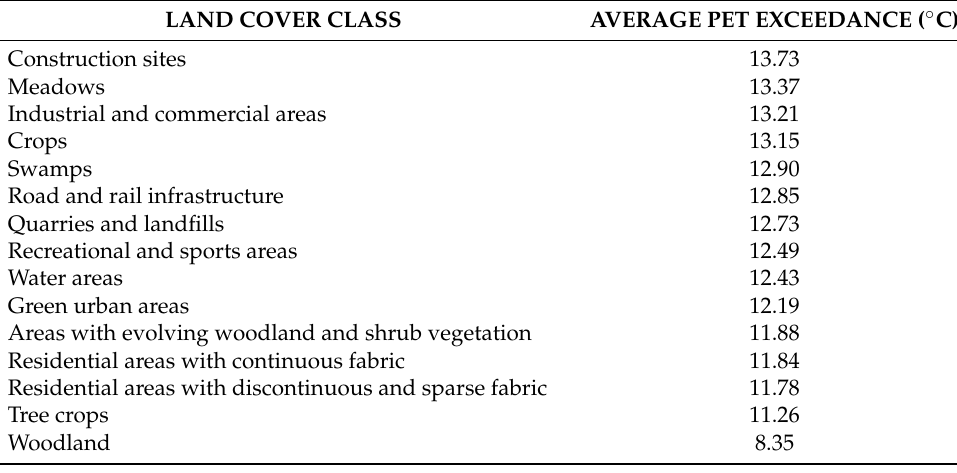
Table 6. Average PET exceedances ( ◦ C) according to land cover